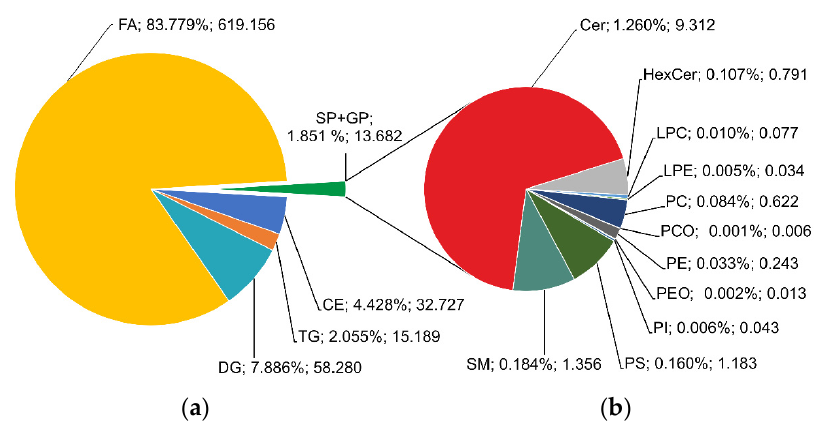
Figure 11. Total ( a ) and sectional ( b ) pie charts of summed relative content and average concentrations of lipids in classes (in % and µ